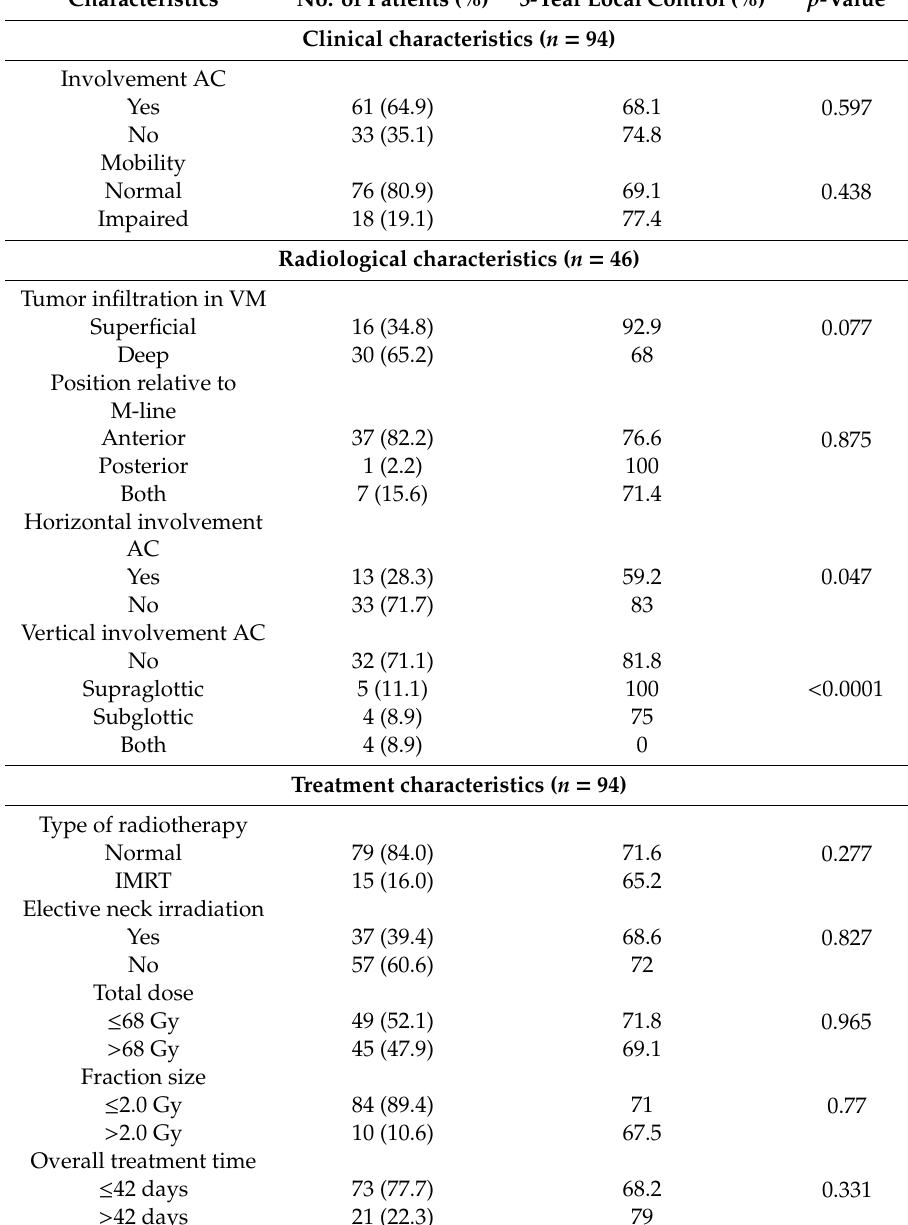
Table 1. Univariate analysis for impact on local